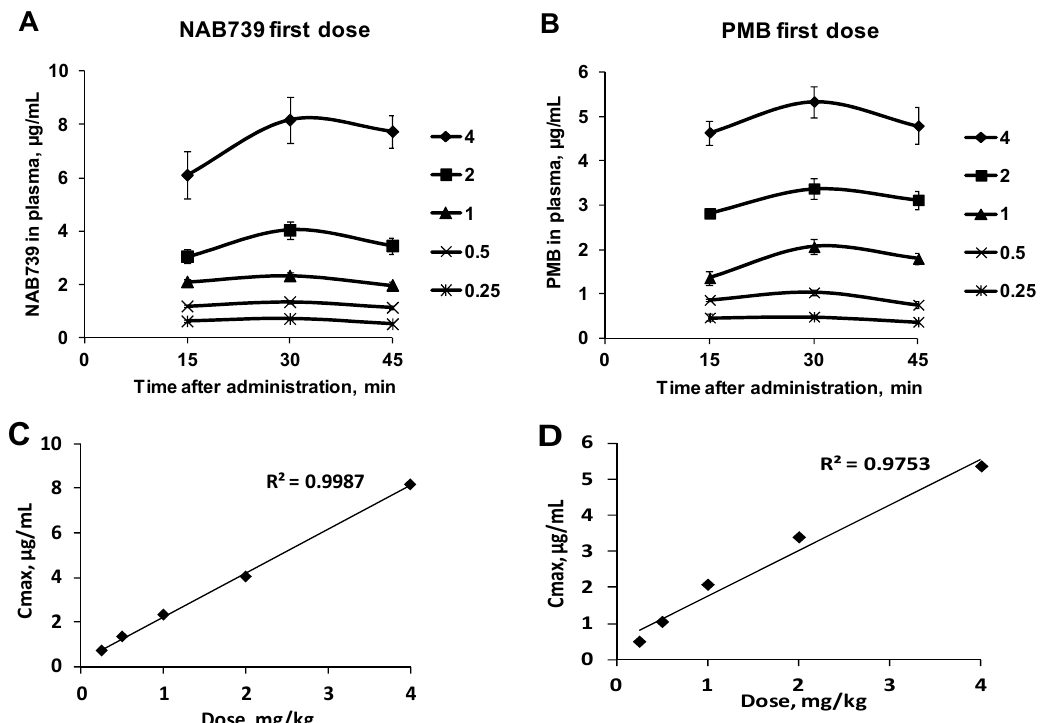
Figure 2. Concentrations of compounds in NMRI mice plasma after the first SC administration of NAB739 ( A ) and PMB ( B ) at doses of 0.25–4mg/kg. Dose and C max relationship of NAB739 ( C ) and PMB ( D ) at doses of 0.25–4 mg/kg. Data expressed as average ± SEM from four mice.